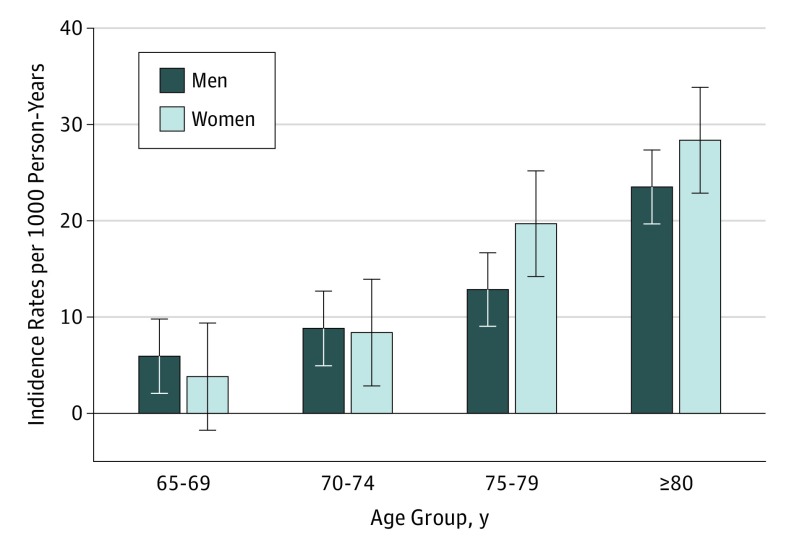
Dementia Incidence Rates Per 1000 Person-Years in Men and Women Presented by
Age-Groups in the English Longitudinal Study of AgeingError bars indicate 95% CIs.